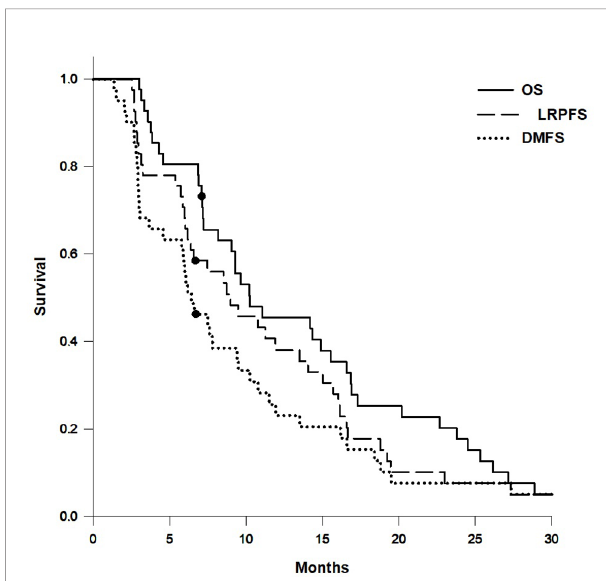
FIGURE 3 | Survival curves of overall survival (OS), locoregional progression- free survival (LRPFS), and distant metastasis-free survival (DMFS) for the whole